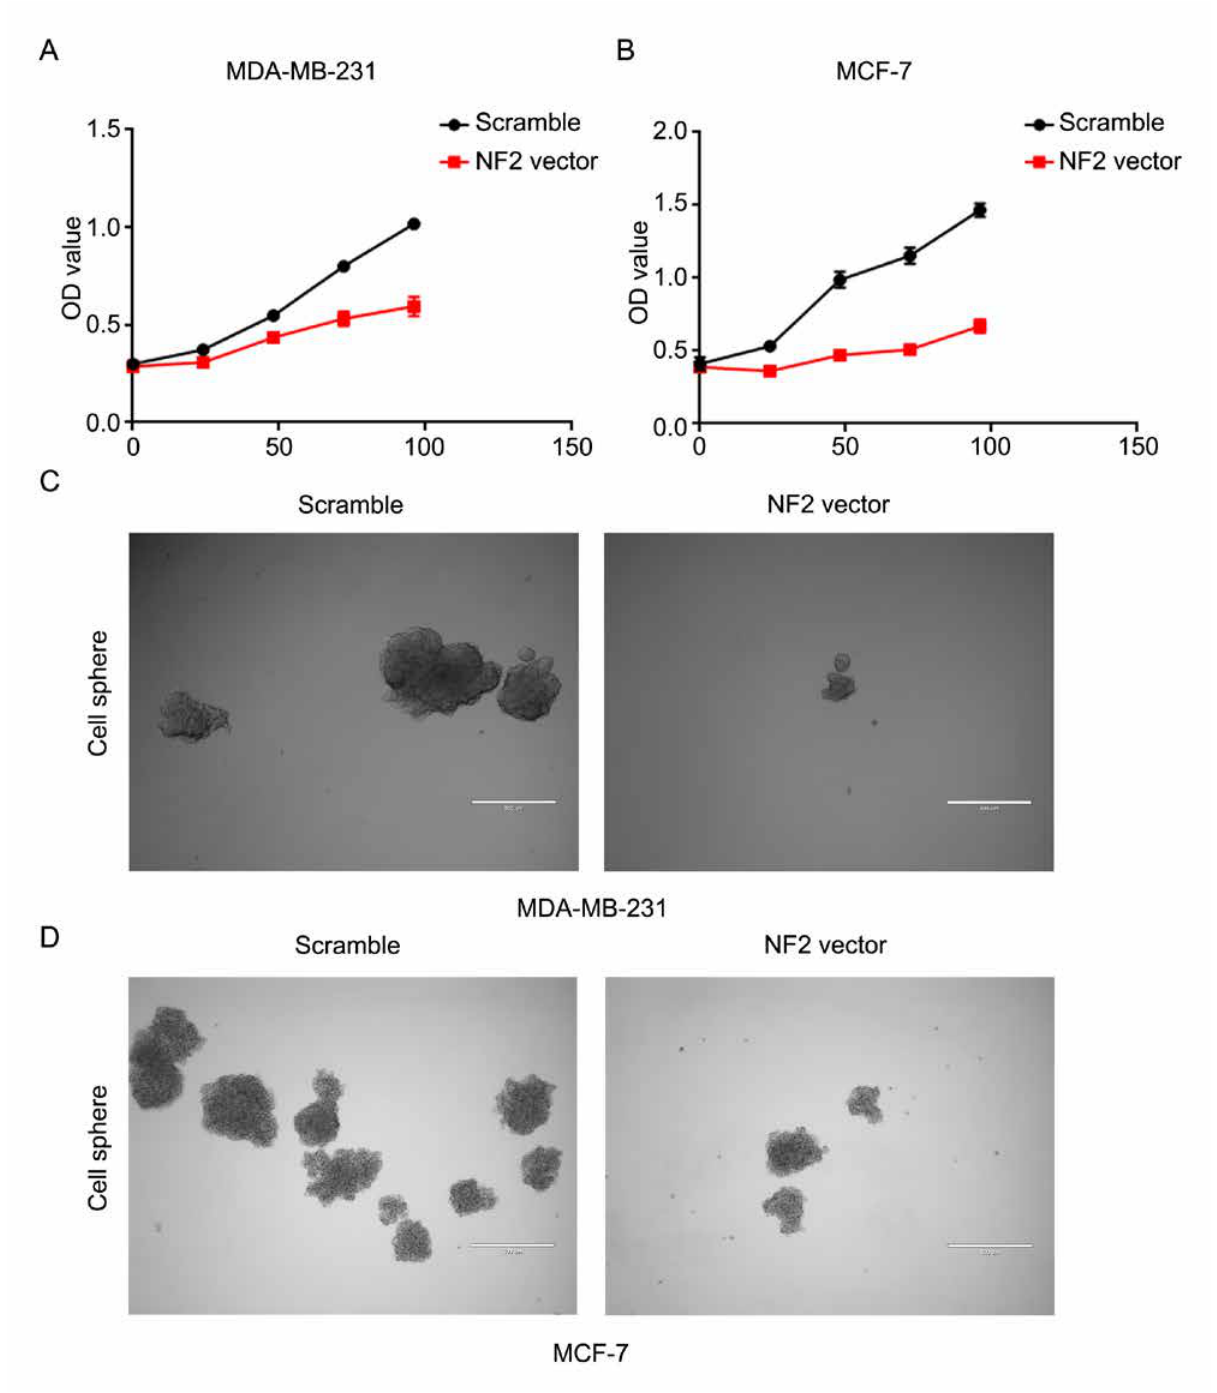
Figure 4: A Proliferation curves of scramble and NF2 vector transfected MDA-MB-231 cells. B Proliferation curves of scramble and NF2 vector transfected MCF-7 cells. C Representative images of in vitro sphere-formation assay of NF2 overexpression in MDA-MB-231 cell and control cell. D Representative images of in vitro sphere-formation assay of NF2 overexpression in MCF-7 cell and control